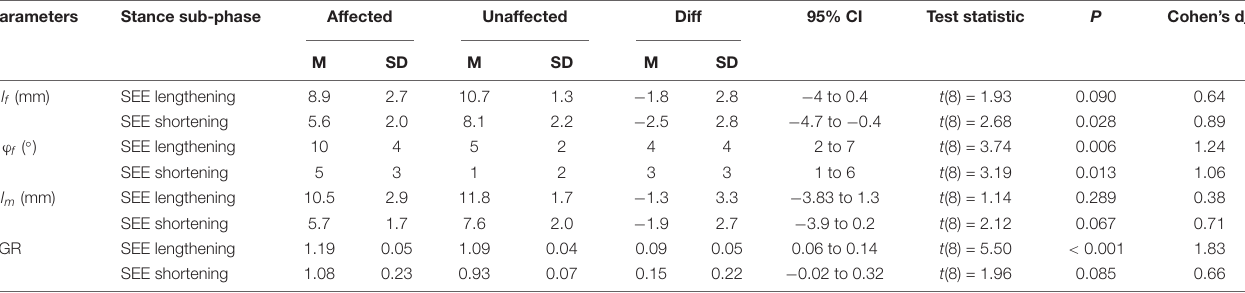
TABLE 3 | Changes in muscle architecture of the gastrocnemius medialis muscle during the series elastic element (SEE) lengthening and shortening sub-phases. Parameters Stance sub-phase Affected Unaffected Diff 95% CI Test statistic P Cohen’s d